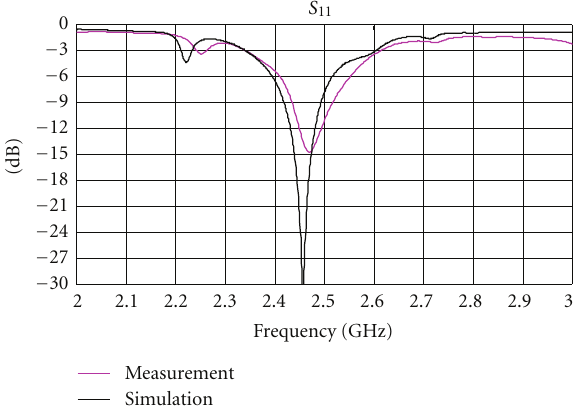
Figure 34: Comparison of the measured and simulated return loss.